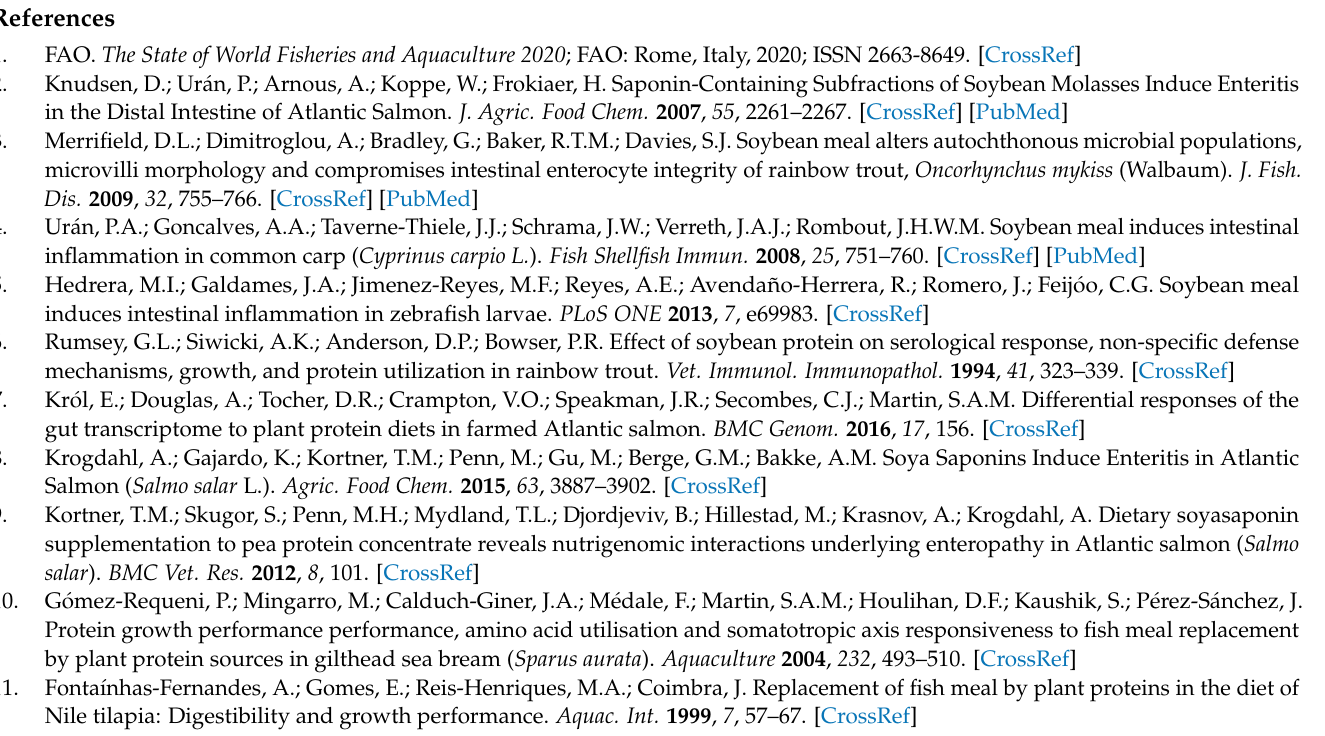
Table S5: Histological variables measured in the posterior intestines of LG-vs. HG-50 SBM + 2SPN and 100FM